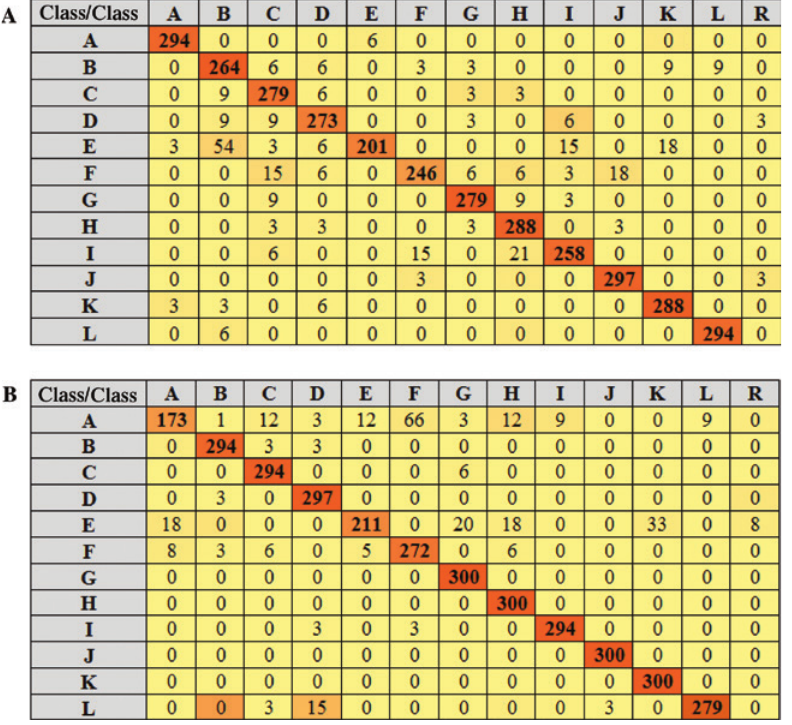
Figure 8: Class-Wise Classification Statistics on Text-Line-Level Script Datasets Using (A) GLCM and (B) Gabor Wavelet